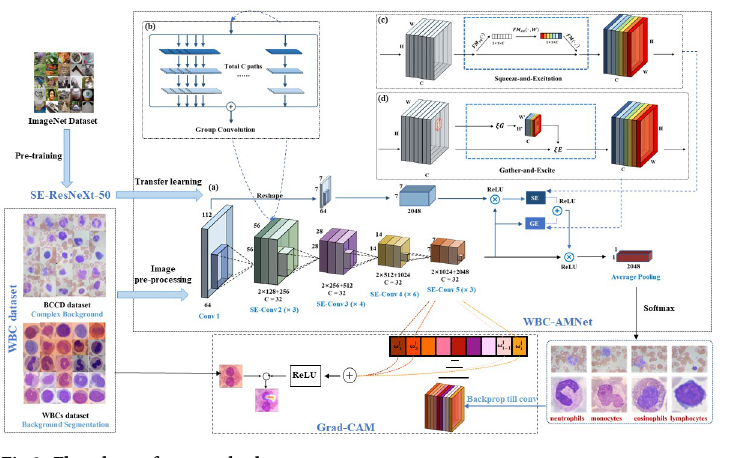
Fig 2. Flowchart of our